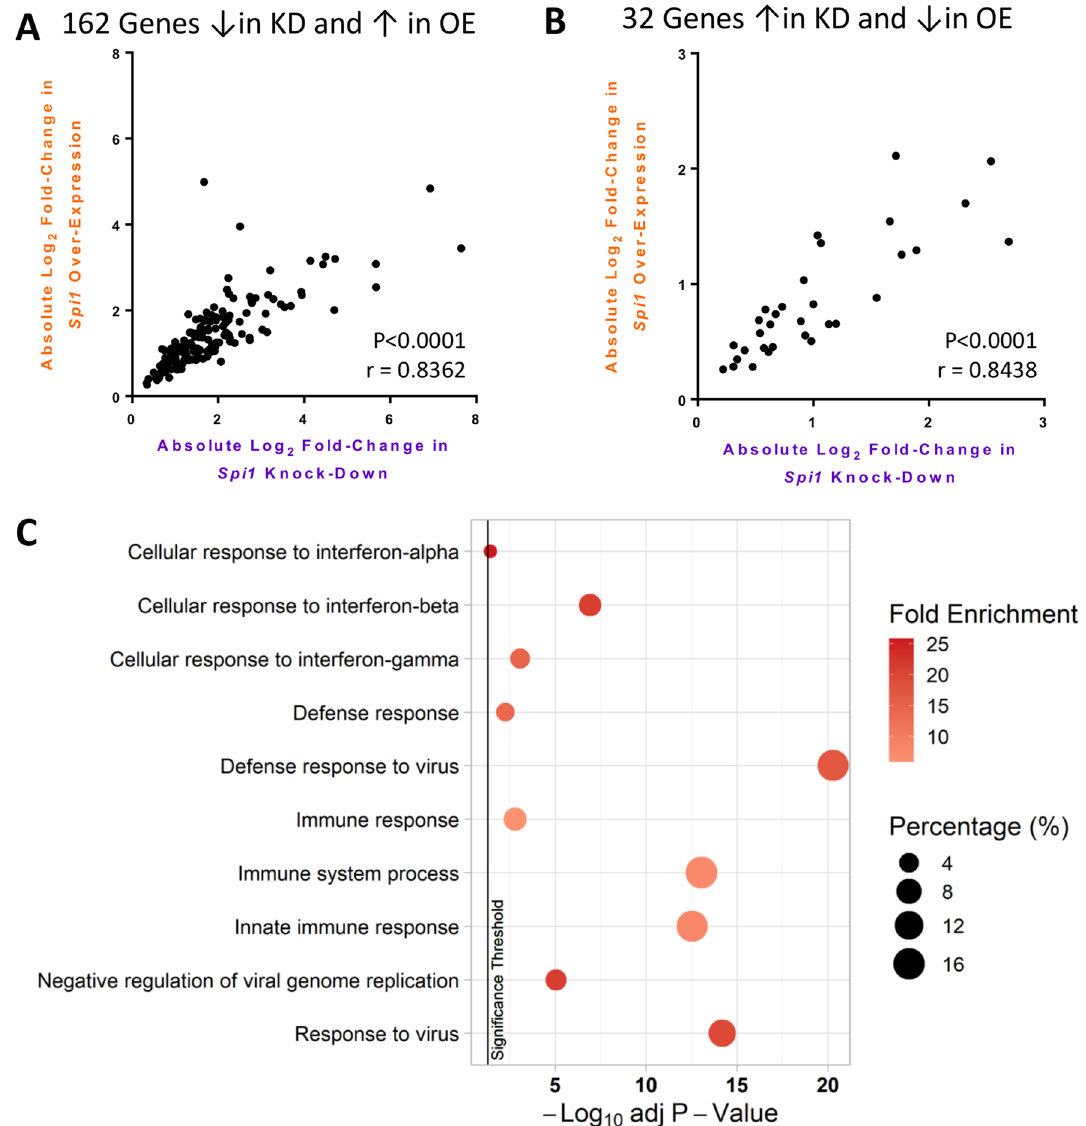
Figure 3. Absolute Log 2 fold-changes in Spi1 dose-sensitive genes. ( A ) Absolute log 2 fold-change values were used the 162 genes where p ≤ 0.05 with negative fold-change values in the Spi1 knock-down dataset (purple) and positive fold-change values in the Spi1 over-expression dataset (orange) were assessed separately from the 32 genes where p ≤ 0.05 and Spi1 dose had the opposite effect on expression ( B ). Two-tailed Spearman Rank test identified significant correlations between the log 2 fold-changes in both graphs (approximate p < 0.0001 and r > 0.8). ( C ) Top 10 most significantly altered “Biological Processes” according to the Benjamini–Hochberg adjusted p value. The bubble size indicates the percentage of the gene list aligned to this pathway. The colour indicates the fold enrichment, which is the proportion of genes present in this list compared to the background gene expression. The vertical black line indicates the p value threshold of 0.05. Figures ( A , B ) were made in GraphPad PRISM 6 (version 3.07) and ( C ) using the ‘tidyverse’ 37 and ‘ggpubr’ 38 packages in R 39,40